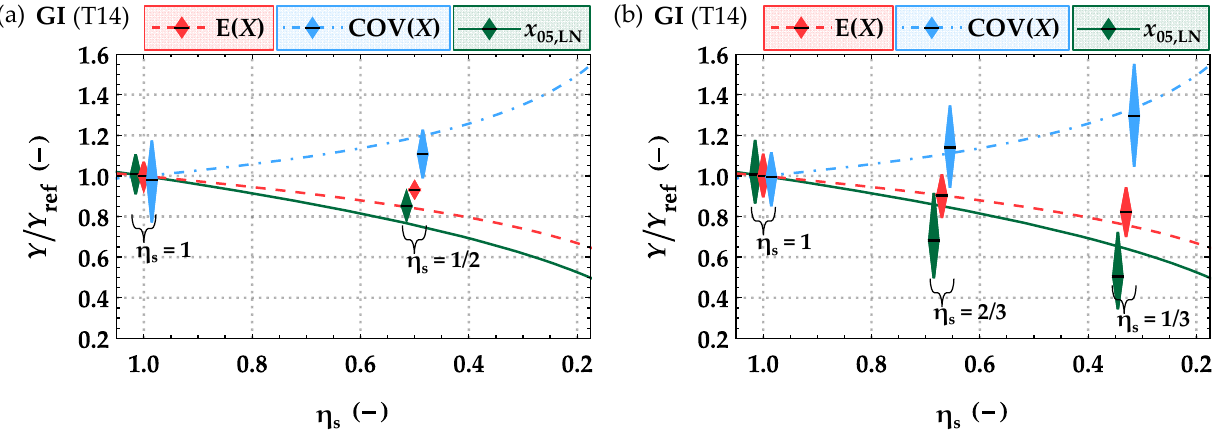
Figure 14. Model predictions vs. the main statistics Y = {E( X ); COV( X ); x 05,LN } from test results ( X = f t,0,b ) relative to properties of boards at full width with 95% CI assuming X ~ LN; data taken from ( a ) Kastner et al. [17] and ( b ) own investigations (see Scherfler [33] for further details). Table 9. Results from the tensile tests parallel to the grain on boards for different separation ratios;